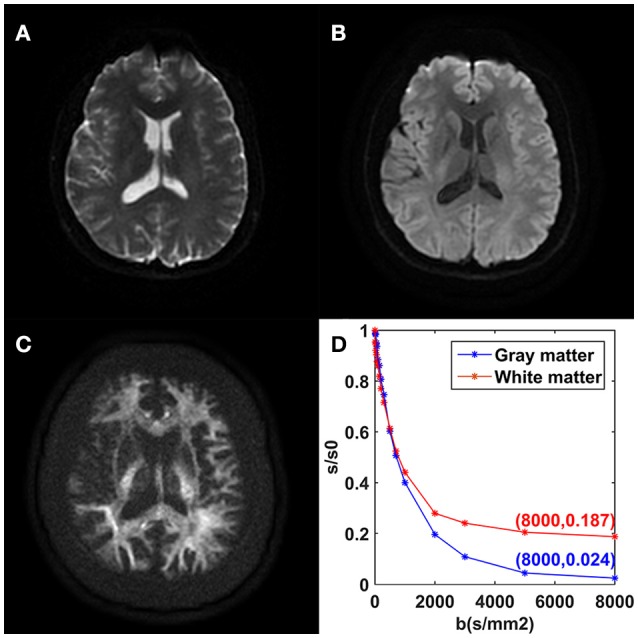
DWI images achieved with b = 0 (A), b = 1,000 (B), and b = 8,000 s/mm2
(C) from one volunteer. Plots of the average signal-intensity decay of two ROIs as a function of b
(D). CG, cingulate gyrus; CCg, genu of the corpus callosum.